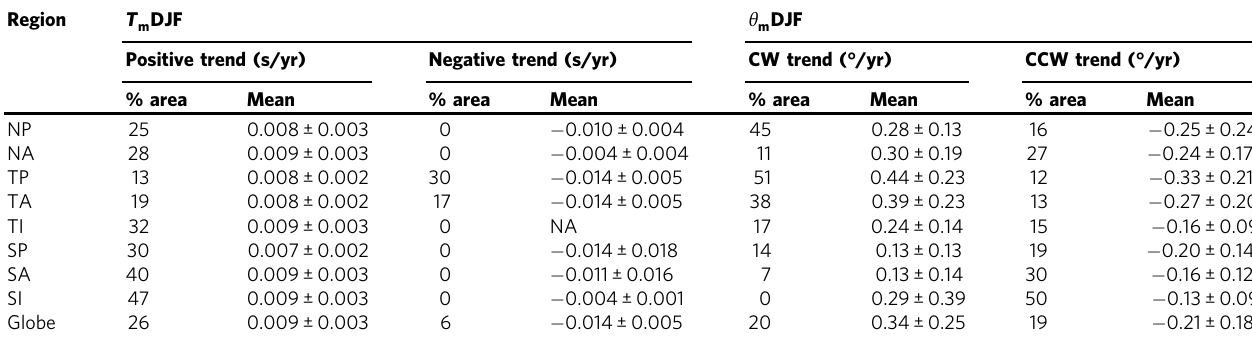
Table 4 Ensemble mean trends and percent area experiencing robust signals of change for T m (seconds per year) and θ m (degrees per year) for the DJF